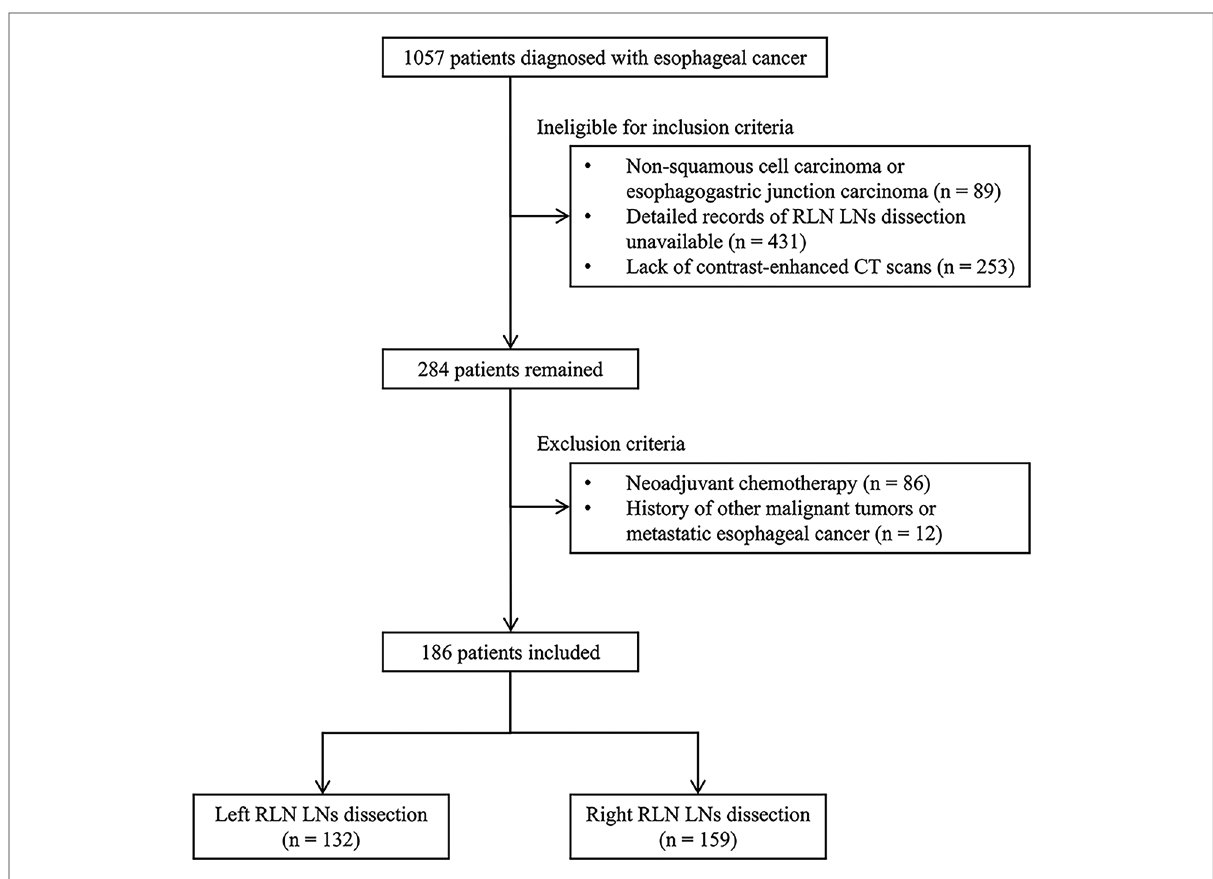
FIGURE 1 The selection process for including eligible patients in this study. RLN LNs, recurrent laryngeal nerve lymph nodes; CT, computed